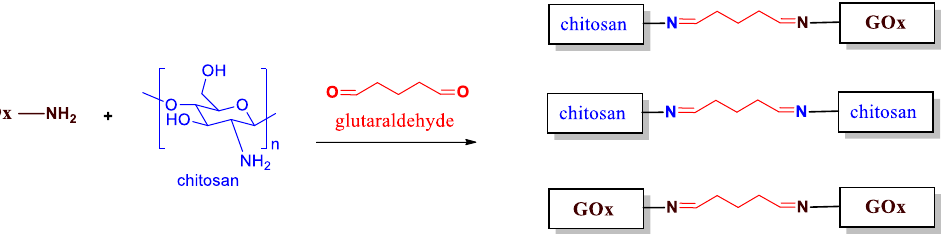
Figure 2. Immobilization process of the enzyme GOx into the chitosan polymer using the glutaral- dehyde crosslinker (added at 2 wt%).